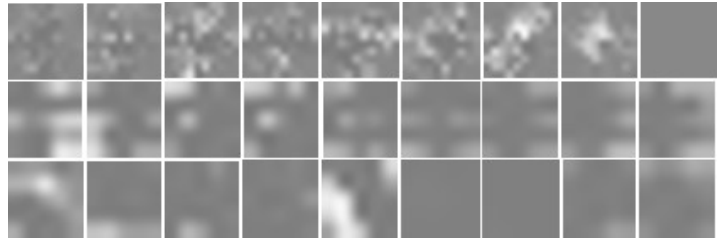
Figure 3. Output features of the middle layer of the deep